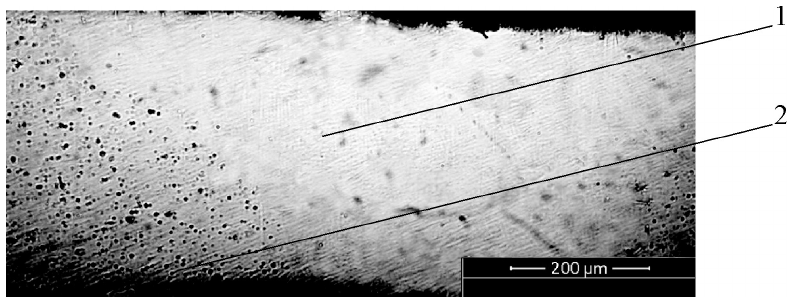
Figure 7. Structure of the material in the cross section of the laser welding zone of the NiCr25WTi nickel-based superalloy: 1—melting area; 2—initial structure [102]. nickel-based superalloy: 1—melting area; 2—initial structure